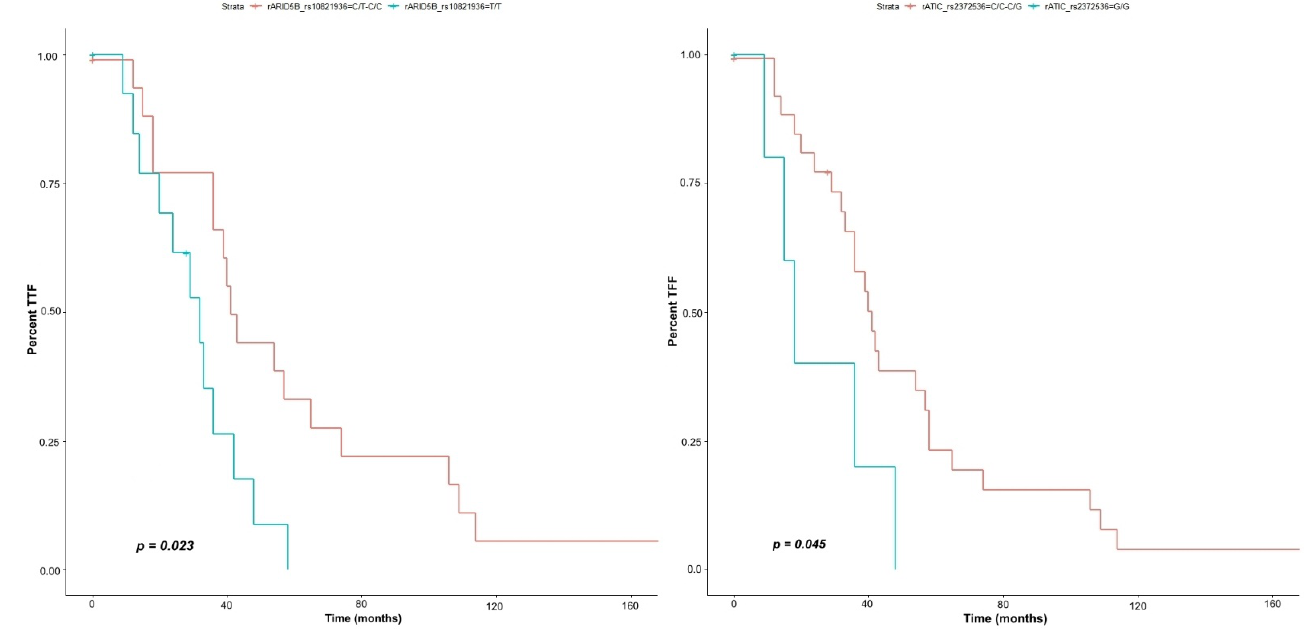
Figure 1. Kaplan–Meier curve demonstrating time of treatment failure (TTF) associated with rs10821936 of ARID5B gene and rs2372536 variant of ATIC . rs10821936 of ARID5B gene and rs2372536 variant of ATIC